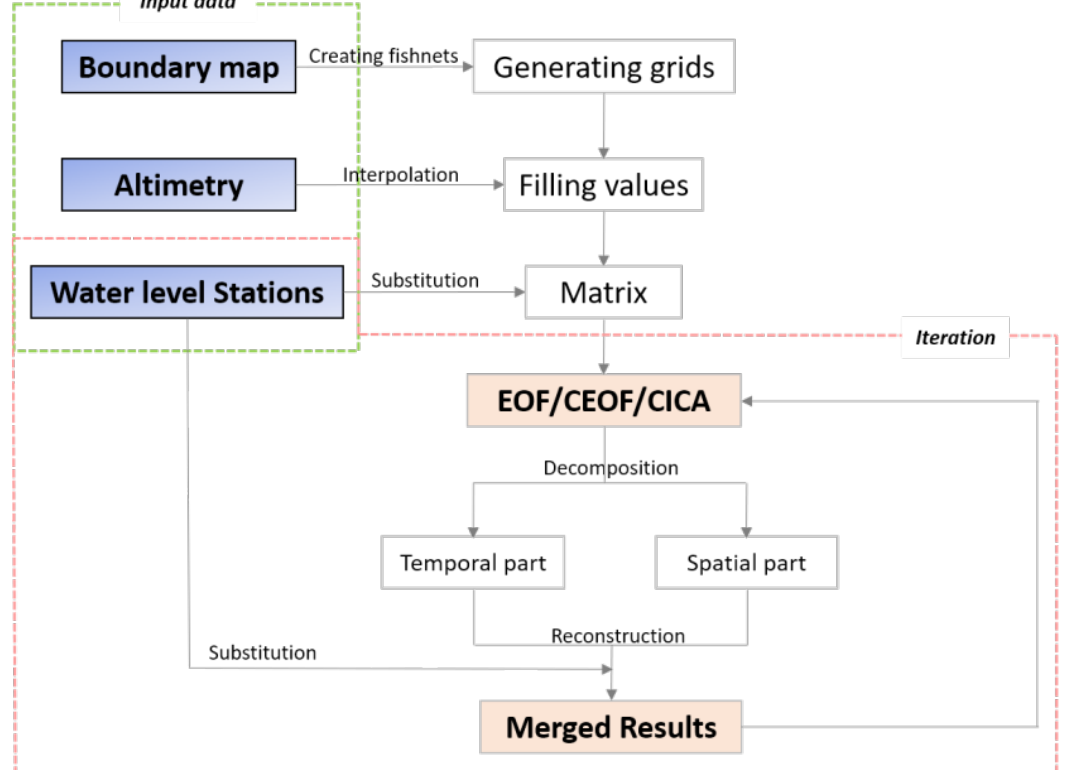
Figure 3. Flow chart describing the main steps of the reconstructed algorithm used in this study.